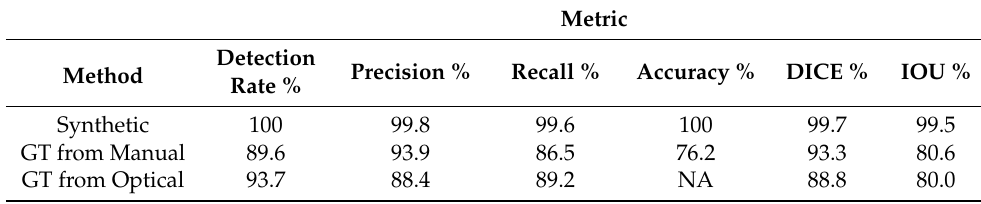
Table 1. A comparison between three segmentation validation